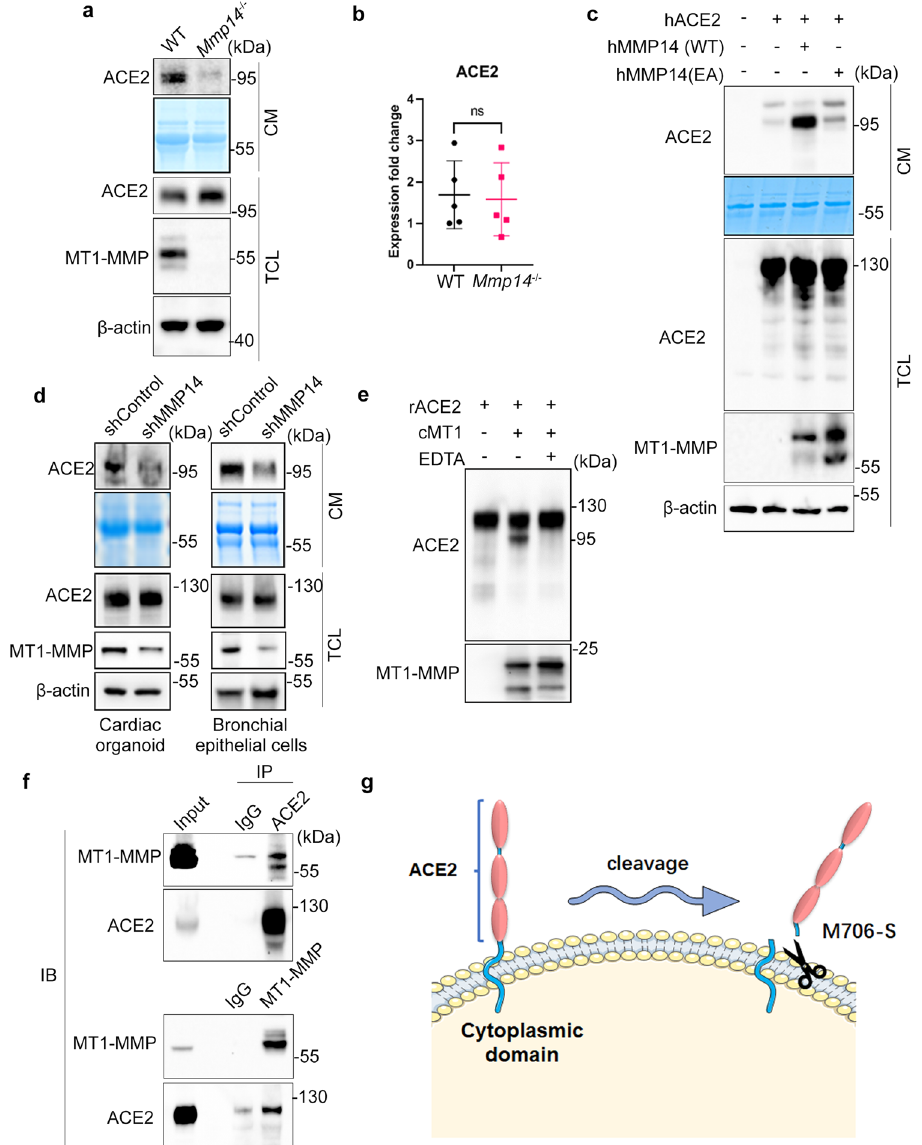
Fig. 1 | The shedding of ACE2 by MT1-MMP. a Western blotting analyses on the expression of ACE2 in the total cell lysate (TCL) and conditioned medium (CM) derived from wild-type and Mmp14 -/- mouse primary lung epithelial cells. Coo- massie stained membrane served as a loading control for conditioned medium ( n =3). b Real-time quantitative PCR analyses on the relative mRNA expression of ACE2 in wild-type and Mmp14 -/- mouse primary lung epithelial cells ( n =5). c HEK293T cells were co-transfected with human ACE2 and wild-type or E/A cata- lytic mutant MT1-MMP (MT1 E240A). Expression of full-length ACE2 in total cell lysates and conditioned medium was detected by western blotting. Coomassie stained membrane was a loading control for conditioned medium ( n =3). d Westernblottinganalysesontheexpressionof solACE2andmemACE2inhuman